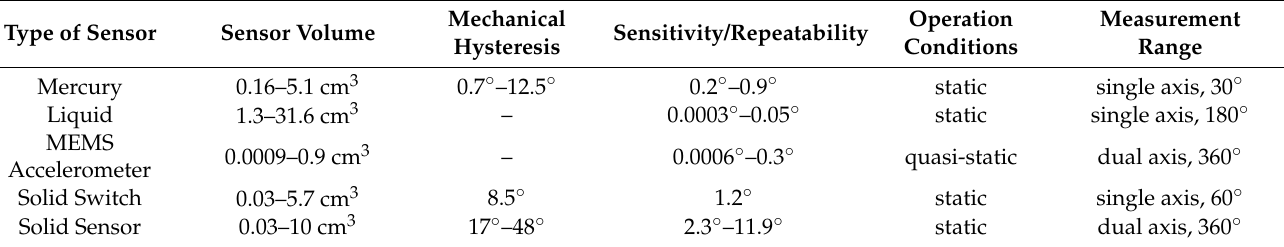
Table 3. Features of various tilt